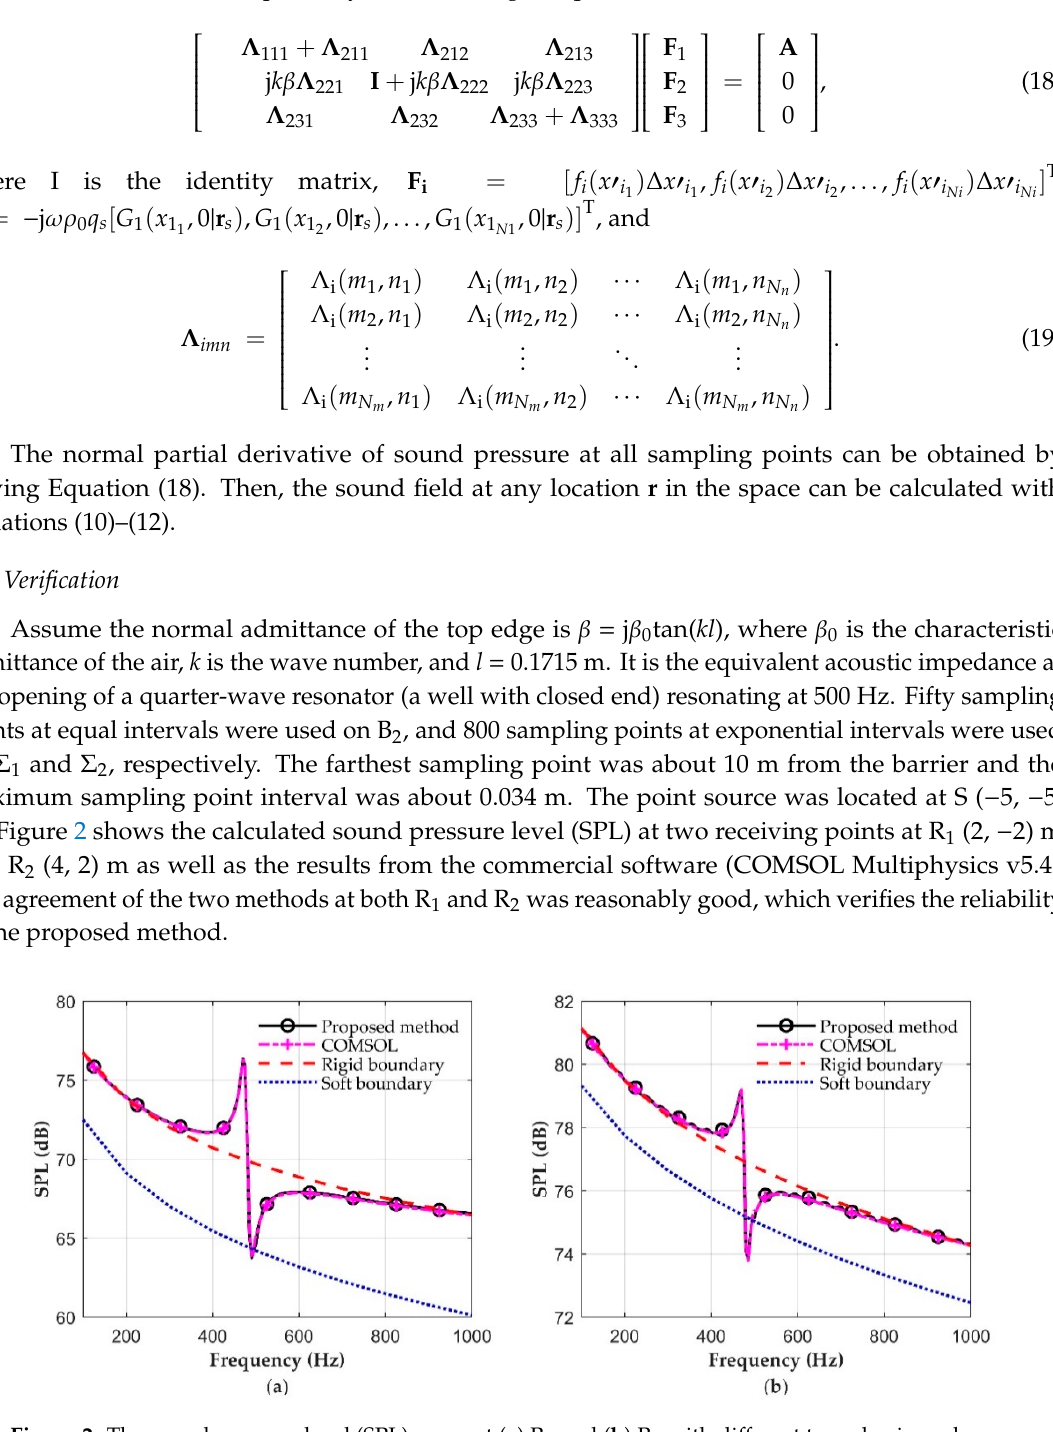
Figure 2. The sound pressure level (SPL) curve at ( a ) R 1 and ( b ) R 2 with different top edge impedance.